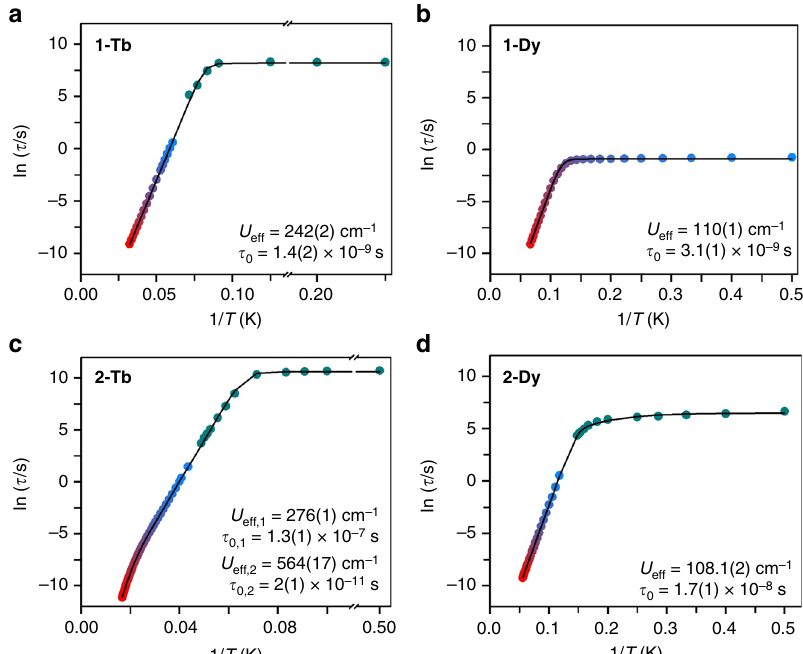
Fig. 4 Arrhenius plots for radical complexes. Plots of the natural log of the relaxation time, τ (blue to red circles), vs. the inverse temperature for a 1-Tb , b 1-Dy , c 2-Tb , and d 2-Dy . Cyan circles represent data extracted from dc susceptibility measurements. Standard deviations of the relaxation times were determined from a nonlinear least-squares analysis employing the program SolverAid (Version 7) by R. de Levie (Microsoft Excel Macro, 2007); error bars are omitted as they are within the radius of the symbols. The black line corresponds to a fi t of the data in the temperature range of 4 – 31 K for 1-Tb , 2 – 15 K for 1-Dy , 2 – 60 K for 2-Tb , and 2 – 18 K for 2-Dy to multiple relaxation processes (see Supplementary Methods and Supplementary Figs. 32, 39, 45, and